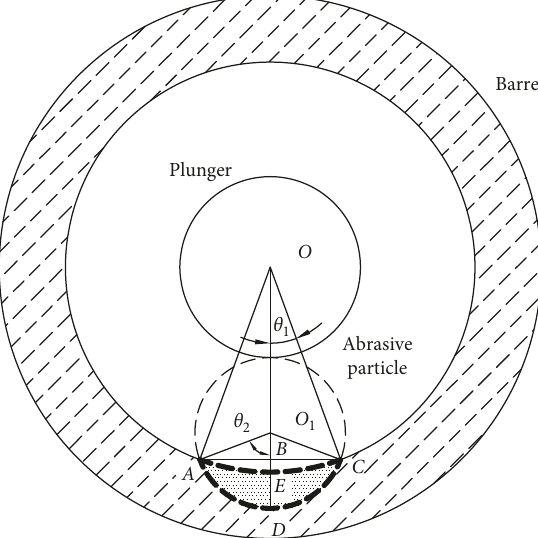
Figure 3: The geometric model of abrasive